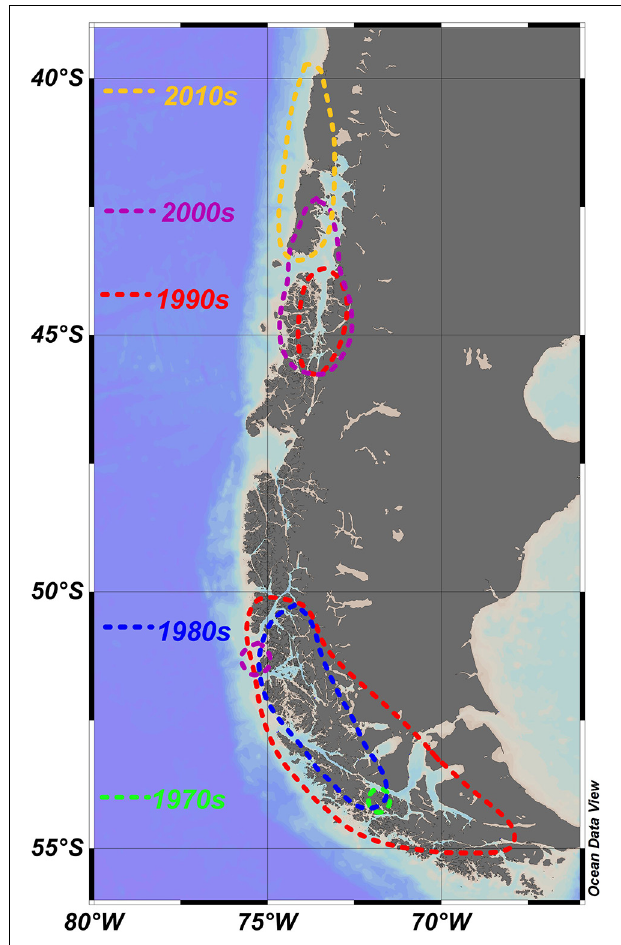
FIGURE 2 | Apparent northward shift of blooms and/or toxic episodes caused by A. catenella ; dotted lines show approximate spread of reports for each decade. Focal points of each of the southerly blooms is also shown in Figure 1 . Associated details are shown in Table 1 . 1970s (Guzmán et al., 1975a,b; Guzmán and Lembeye, 1975; Lembeye et al., 1975). 1980s (Lembeye, 1981a,b; Uribe, 1988). 1990s (Lembeye, 1992; Muñoz et al.,